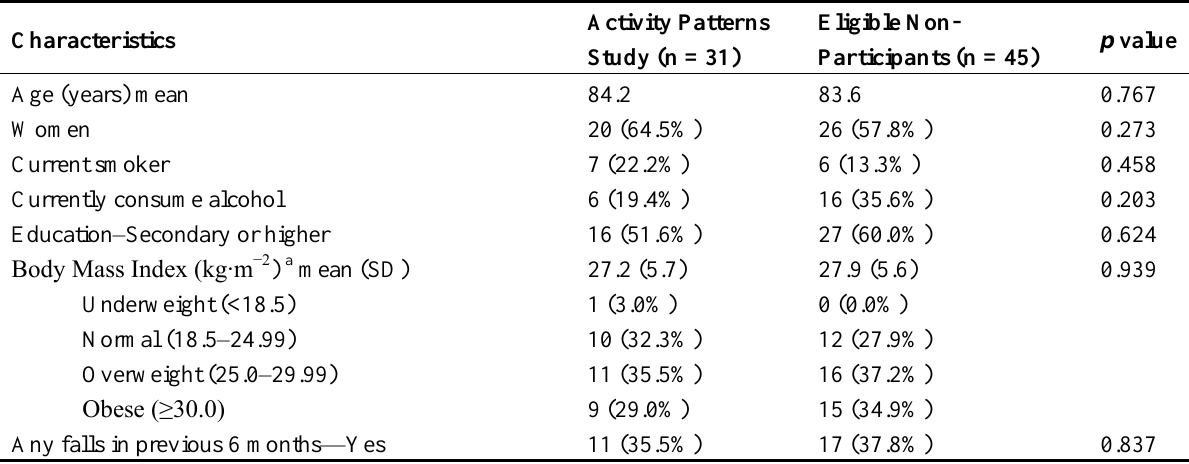
Table 1. Sociodemographic, Physical and Cognitive Characteristics of Activity Patterns Study (n = 31) Participants and Non-Participants (n =